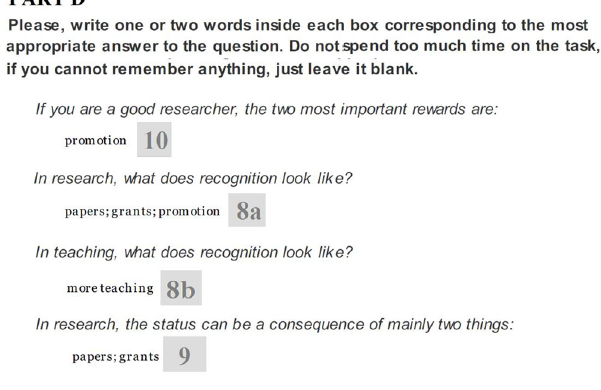
Figure 3. One academic ’ s responses to PART C and PART D